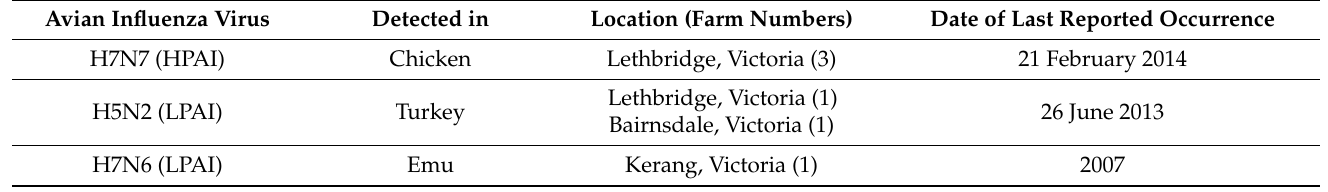
Table 1. Avian influenza A viruses detected during an outbreak in Victoria, Australia, between 31 July and 25 August, 2020. Avian Influenza Virus Detected